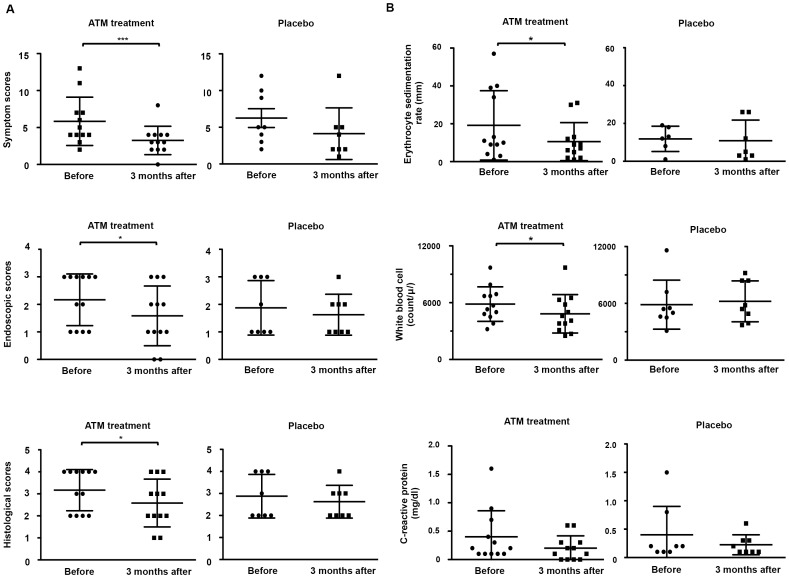
Characterization of the patients with UC.Patients with UC were treated with the ATM therapy (n = 12) or placebo (n = 8) for 2 weeks. (A) The symptom score (upper panel), endoscopic score (middle panel), and histological score (lower panel) at 3 months after the ATM treatment or placebo were compared with the trial start. (B) Inflammatory markers such as the erythrocyte sedimentation rate (upper panel), white blood cell count (middle panel), and C-reactive protein (CRP) (lower panel) at 3 months after the ATM treatment or placebo were compared with the trial start. The results are expressed as the mean ± SD. ***P<0.001; **P<0.01; *P<0.05.